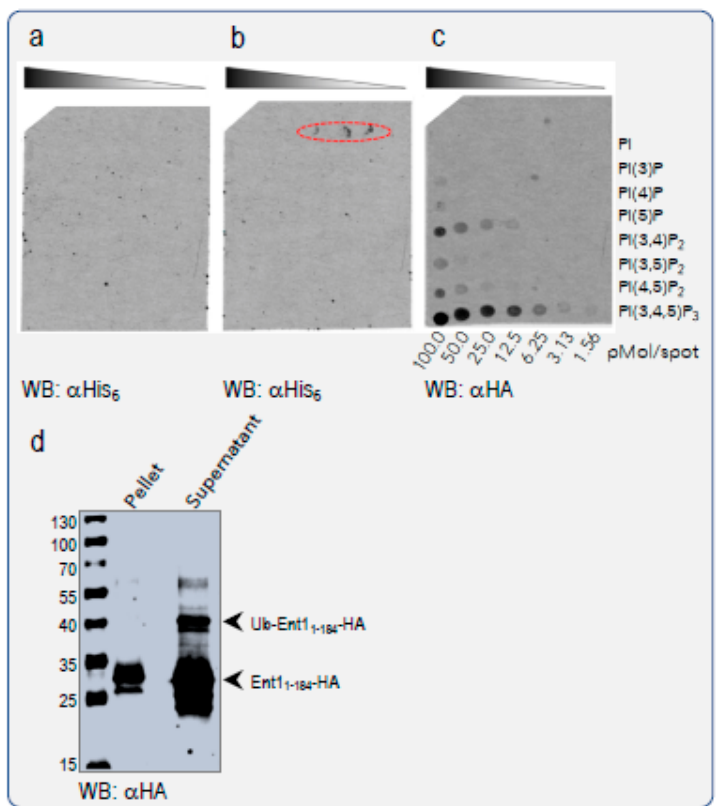
Figure 4. Ent1 and Ub-Ent1 PIPs binding assays in vitro. A 1:1 mix of purified apo and ubiquitylated Ent1 1-184 proteins was assayed for PIPs binding. A PIP array membrane (Echelon) was incubated with the protein mix and washed, as described in the Methods section. Proteins were detected by western blot (WB): apo with anti-His 6 -tag, and ubiquitylated Ent1 with anti-HA antibodies, respectively. ( a ) The PIP-array membrane after a binding assay with the mix and WB against the ubiquitylated Ent1. ( b ) The antibody reaction against ubiquitylated Ent1 that was blotted on the membrane, as described in the Results section. ( c ) The reaction with the HA antibody. The binding to the indicated PIPs is clearly seen as black spots. ( d ) A PI(4,5)P 2 enriched liposome (Echelon) binding assay. A protein mix contained apo and ubiquitylated Ent1 1-184 was used for a pull-down assay with PI(4,5)P 2 enriched liposomes. Following incubation, the liposomes were pelleted by centrifuge. Bound (Pellet) and unbound (Supernatant) proteins were then separated by SDS-PAGE, and detected by WB with anti-HA antibodies.